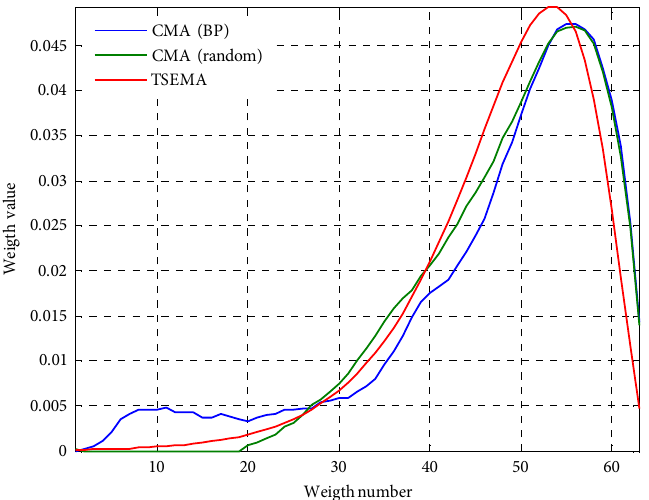
Fig. 6. CMA weights generated using two different datasets and weights of